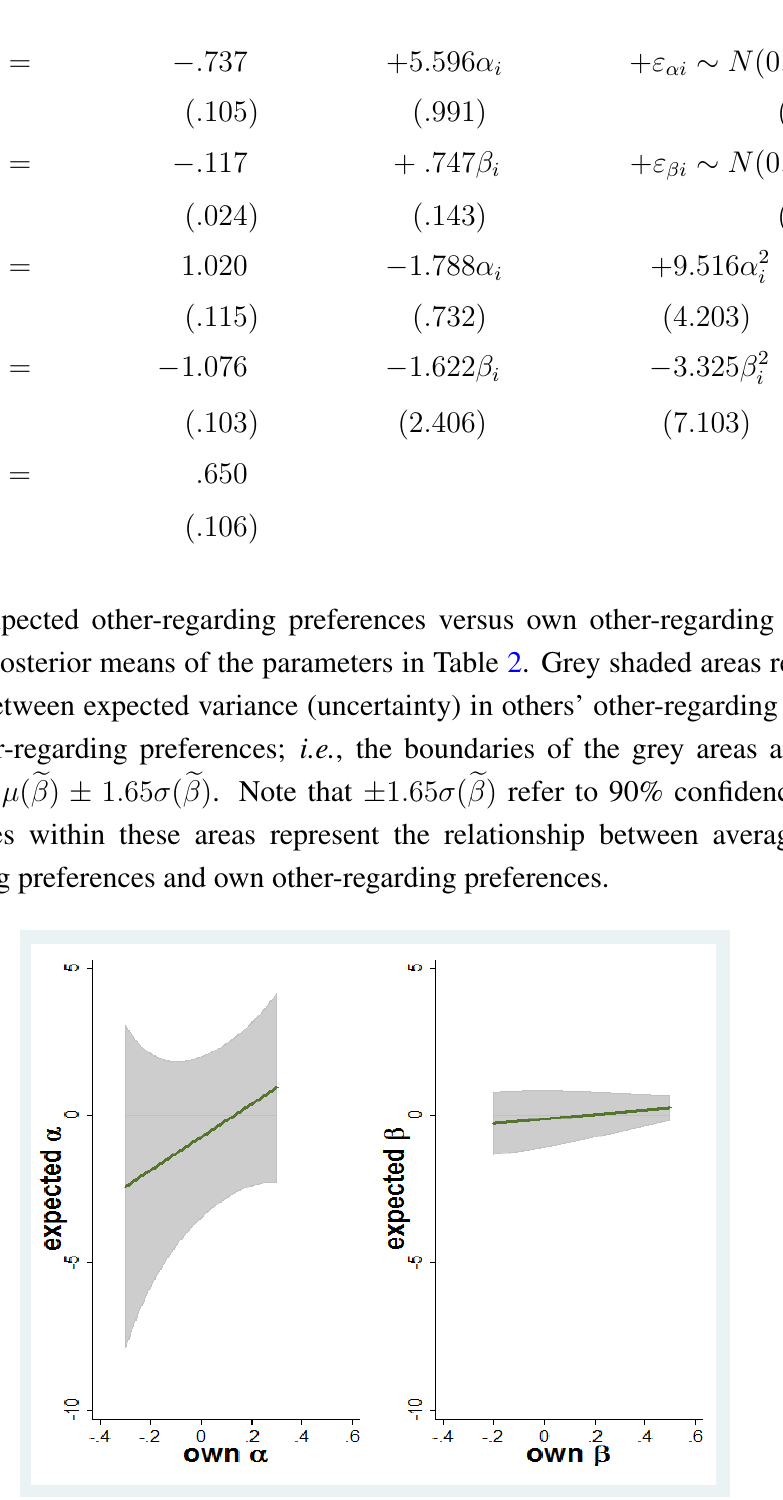
Table 2. Beliefs about others’ other-regarding preferences: Points estimates (posterior means) of the parameters of Equation 5. Posterior standard deviations are given in